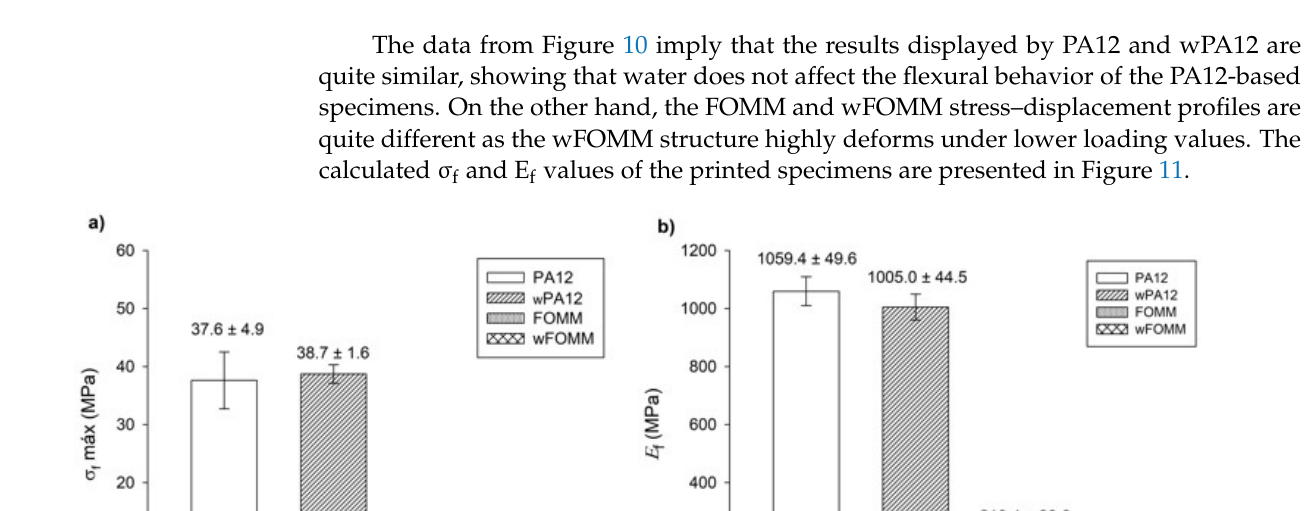
Figure 10. Stress–strain representative 3PB curves of printed specimens.